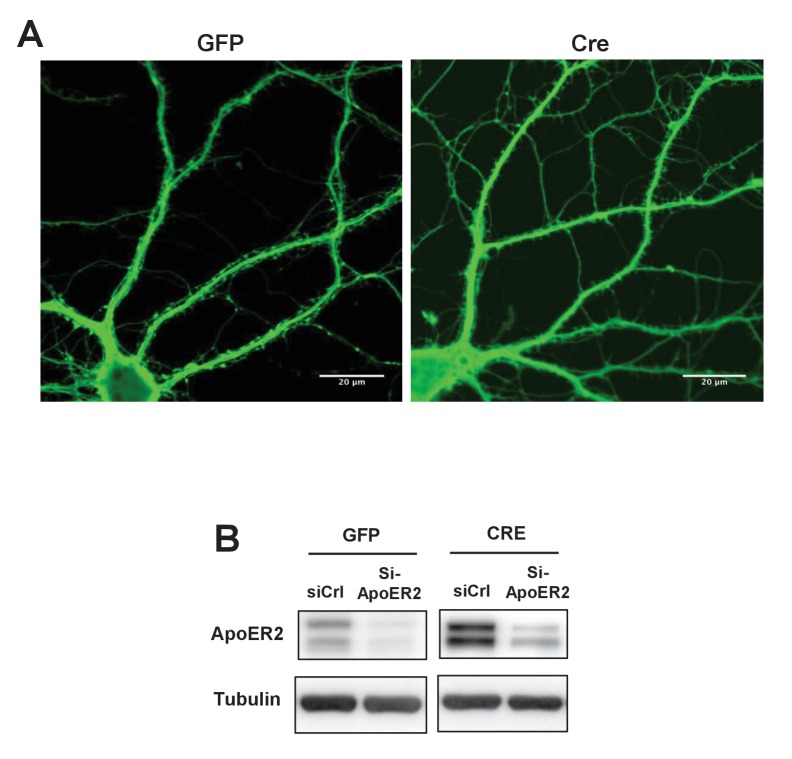
Loss of IDOL impairs dendritic Spine morphogenesis and maturation.(A) Representative images showing morphology of Mylipflox/flox hippocampal neurons transduced with either AAV-CamKII-GFP or AAV-CamKII-CRE-GFP. Neurons were transduced at DIV 5, and fixed and stained at DIV 19–20. Scale bars, 20 µm. (B) Immunoblot analysis of total proteins from Mylipflox/flox hippocampal neurons transduced with either AAV-CamKII-GFP or AAV-CamKII-CRE-GFP, and treated with control siRNA (1 µM) or ApoER2 siRNA (1 µM). Knockdown efficiency was evaluated 72 hr after transfection.